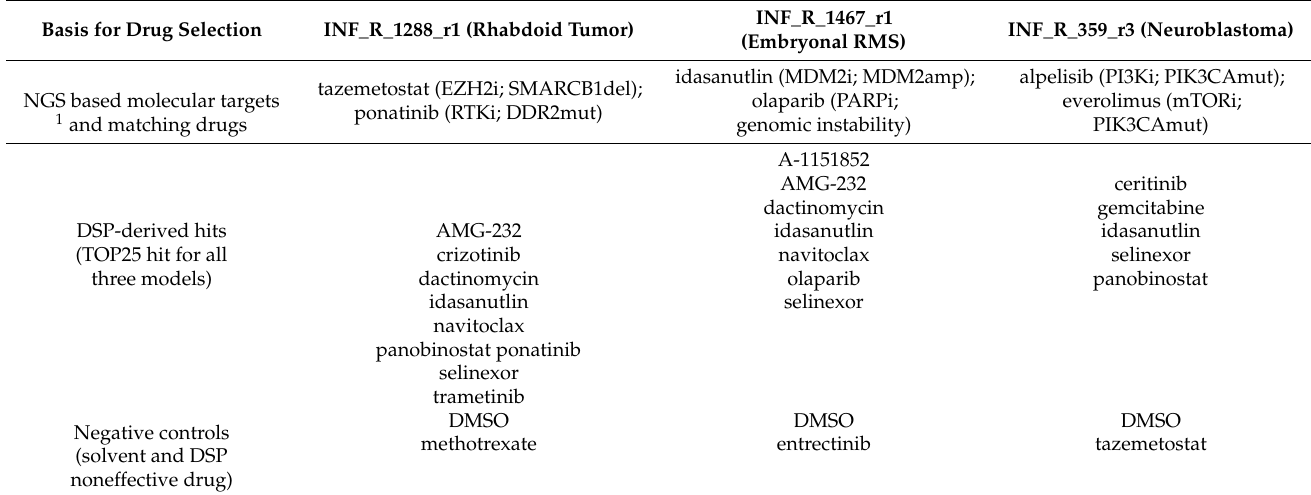
Table 4. Drug selection for zPDX validation.